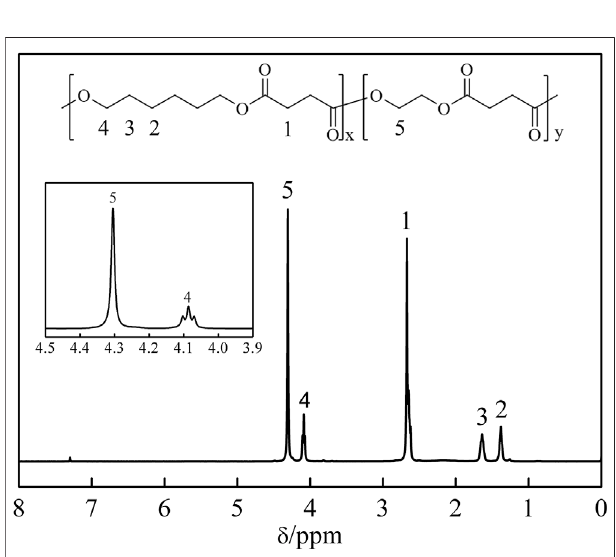
FIGURE 1 | Chemical structure and 1 H NMR spectrum of the prepared P(HS- co -ES76)